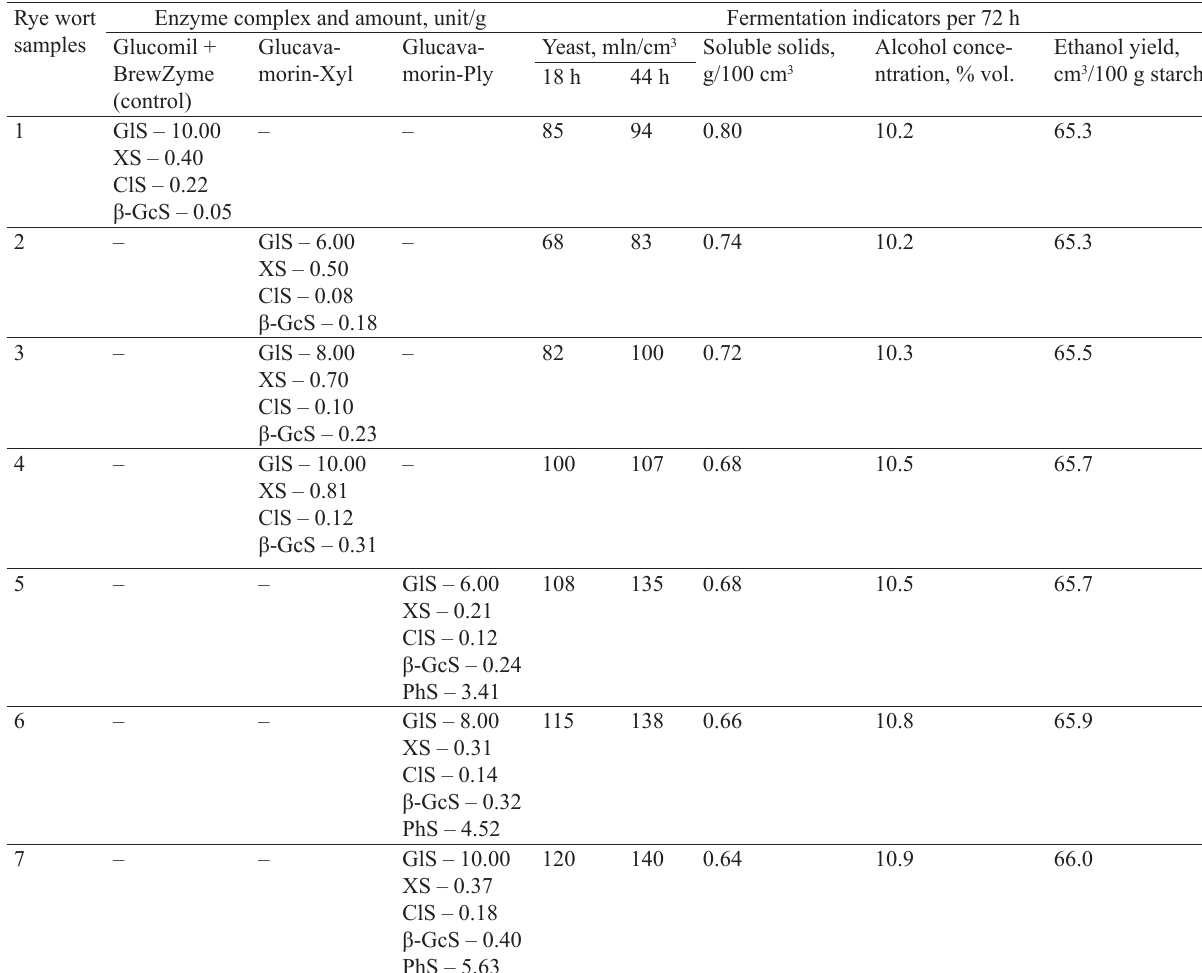
Table 4 Effects of enzyme complexes derived from recombinant strains on the rye wort fermentation Rye wort Enzyme complex and amount, samples